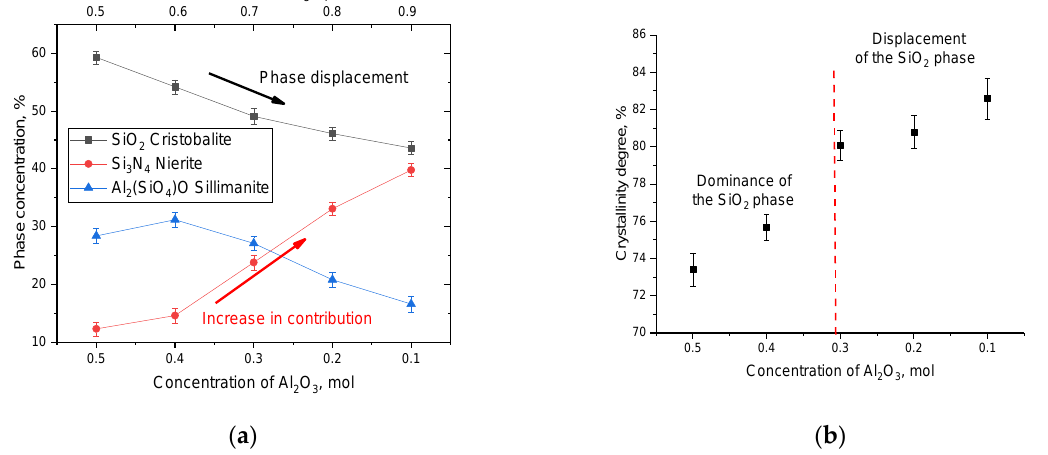
Figure 2. ( a ) Diagram of the phase composition of (1 − x)Si 3 N 4 -xAl 2 O 3 ceramics depending on the variation of the components; ( b ) Graph of the change in the crystallinity degree of xAl 2 O 3 -(1 − x)Si 3 N 4 ceramics depending on the variation of the components (the values of the degree of crystallinity were refined using the Rietveld method).